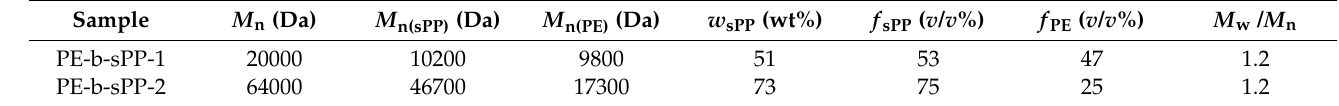
Table 1. Total molecular mass ( M n ), molecular masses of PE ( M n(PE) ) and sPP ( M n(sPP) ) blocks, weight fraction ( w PP ) of the sPP block, volume fractions of the sPP ( f sPP ) and PE ( f PE ) blocks and polydispersity ( M w / M n ) of the samples of PE-b-sPP block